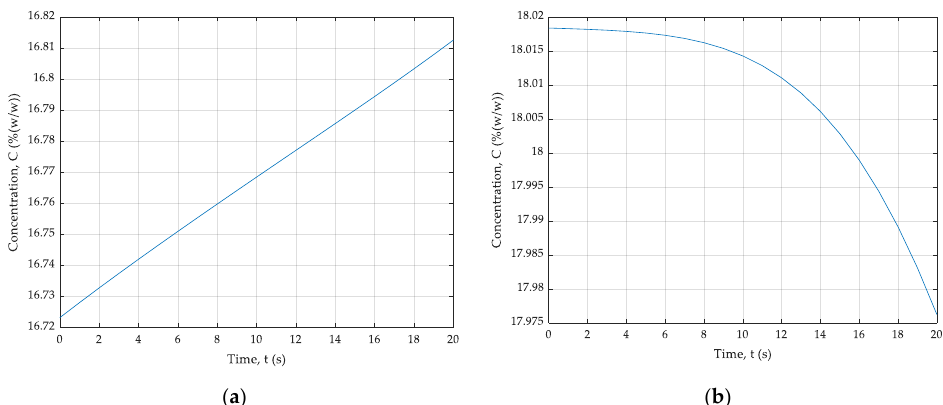
Figure 5. History of the concentration over time without using interval arithmetic: ( a ) from 22 °C to −5 °C and ( b ) from −5 °C to 22 °C.